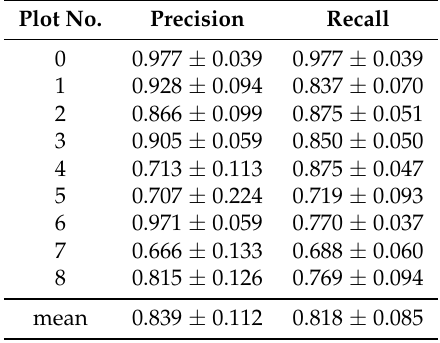
Table 4. Autonomous stump detection results for each plot, averaged over cross-validation folds. Plot